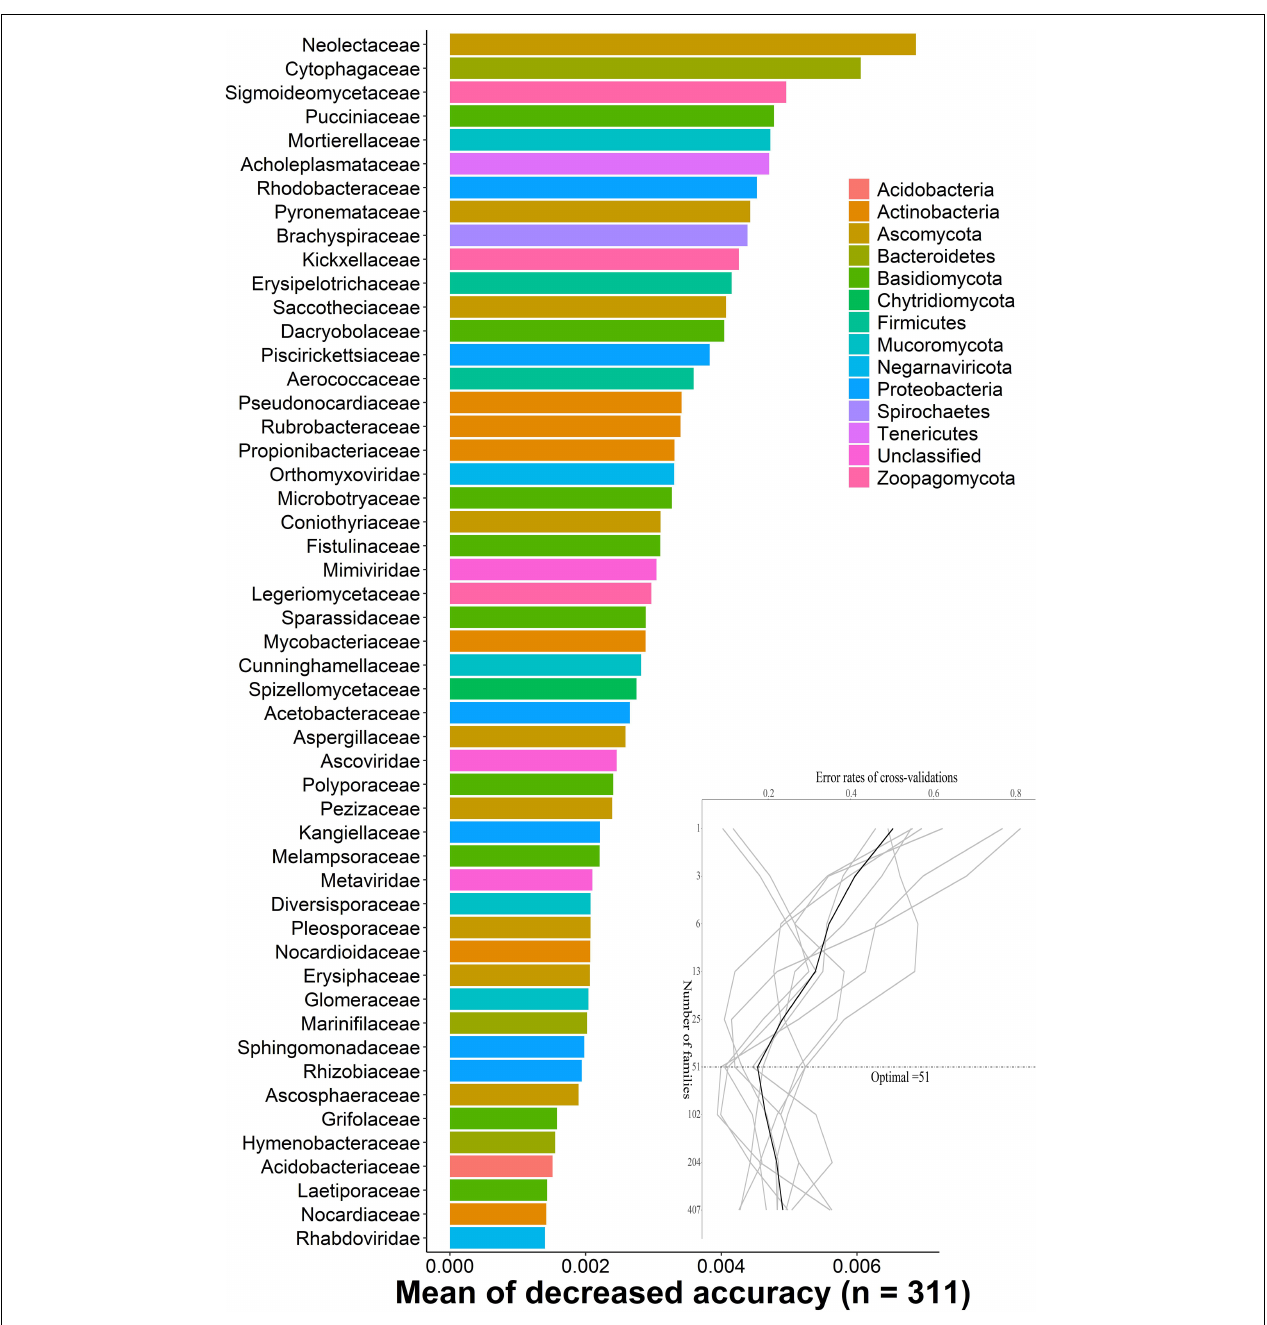
FIGURE 2 | The random-forest model detects bacterial taxa that predict DENV infection. The possible biomarker taxa were ranked in descending order of importance to the accuracy of the model. The inset represents 10-fold cross-validation error as a function of the number of input families used to differentiate microbiota in order of variable